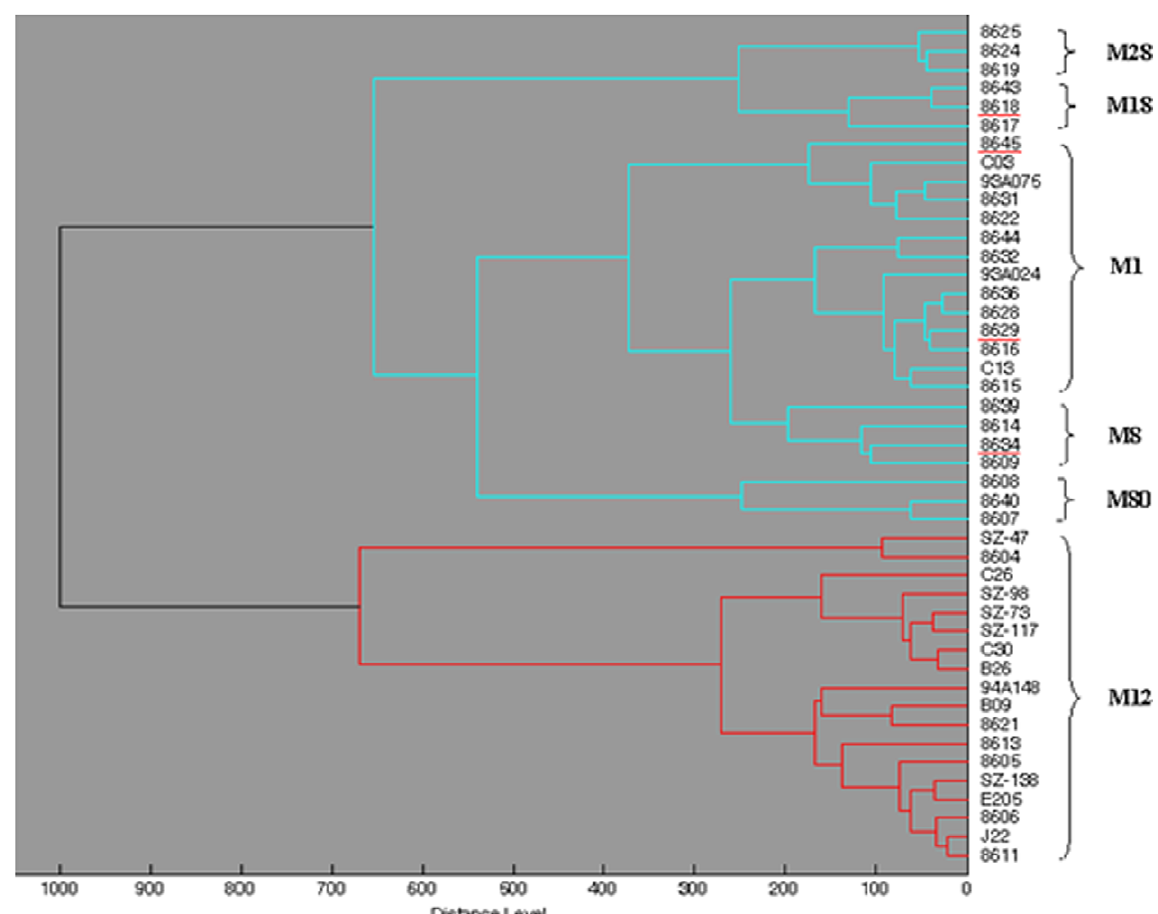
Figure 3. Score Oriented Dendrogram for 44 GAS with M type prevalence in China. At a critical distance level of about 670, the isolates of M12 were clustered into one group and branched compared with the other M types. However, at a critical distance level of about 280, SZ–47 and 8604 were branched, which were wrongly clustered, as shown in Figure 3. At a critical distance level of about 270, 6 groups were generated with minor error, which were M28, M18, two M1 groups, M8 and M80.